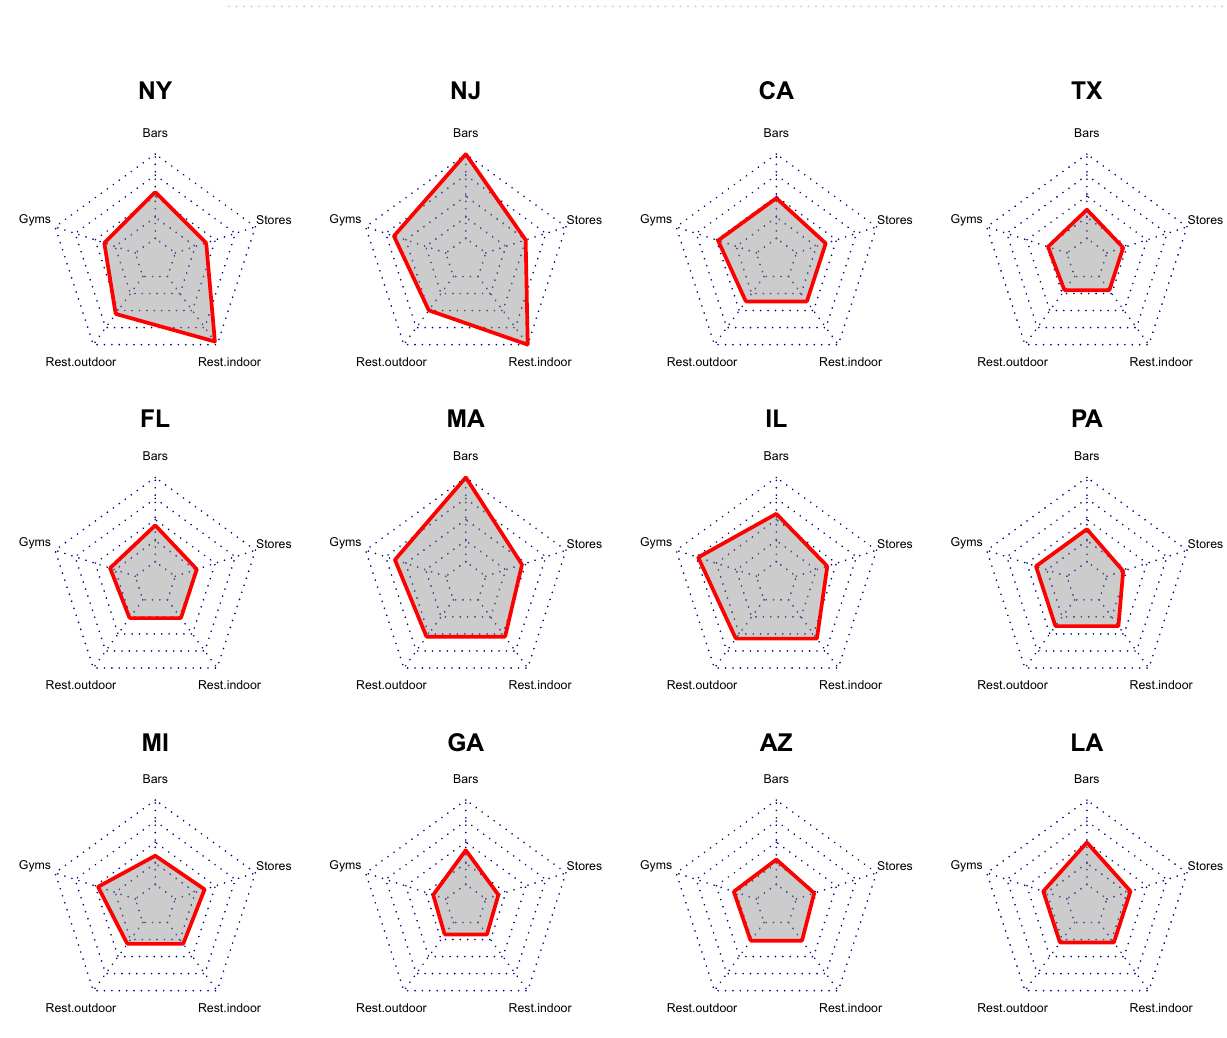
Table 2. The reopening policies of different states. These include the dates of reopening of outdoor restaurants, indoor restaurants, bars, gyms, and stores. The date of the state mask mandate is also listed in the last column. An entry of “NA” indicates that a statewide reopening of the particular category or mask mandate has not been implemented by the September 1st 6 .